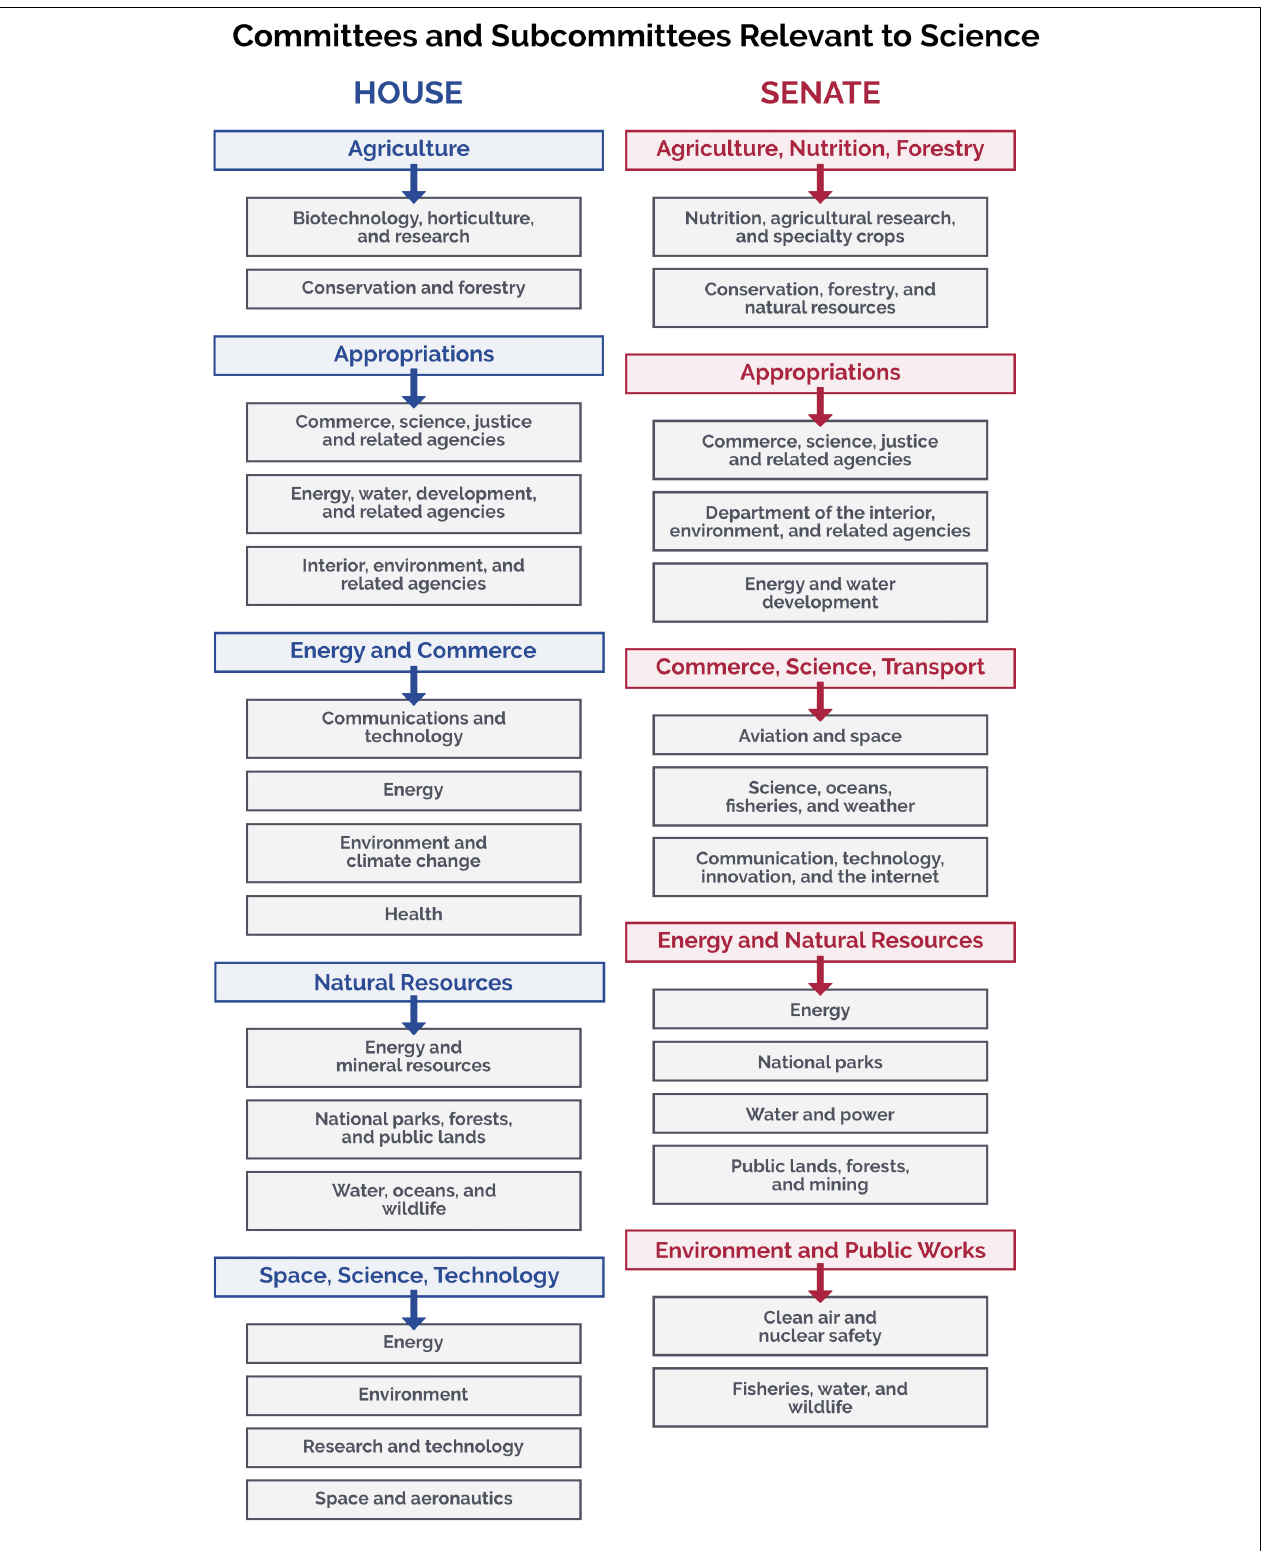
FIGURE 2 | Current 2019 standing committees in the U.S. House of Representatives (blue) and Senate (red) with the highest relevance to science and science policy. Within each committee, numerous subcommittees exist with narrower scopes within science and engineering. We recommend by identifying one to three relevant subcommittees and tracking their actions directly on